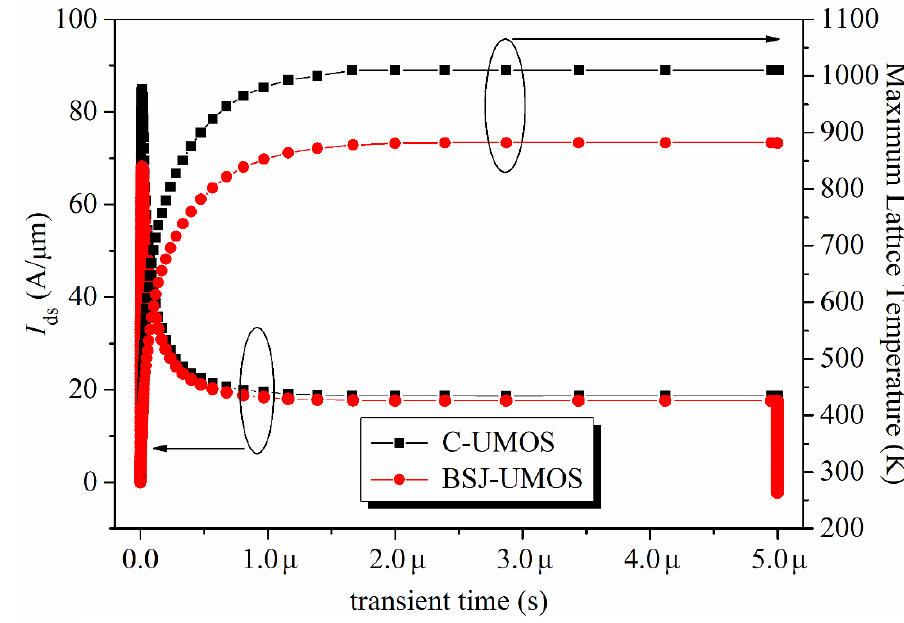
Figure 16. Maximum lattice temperature and drain current for the short-circuit case.